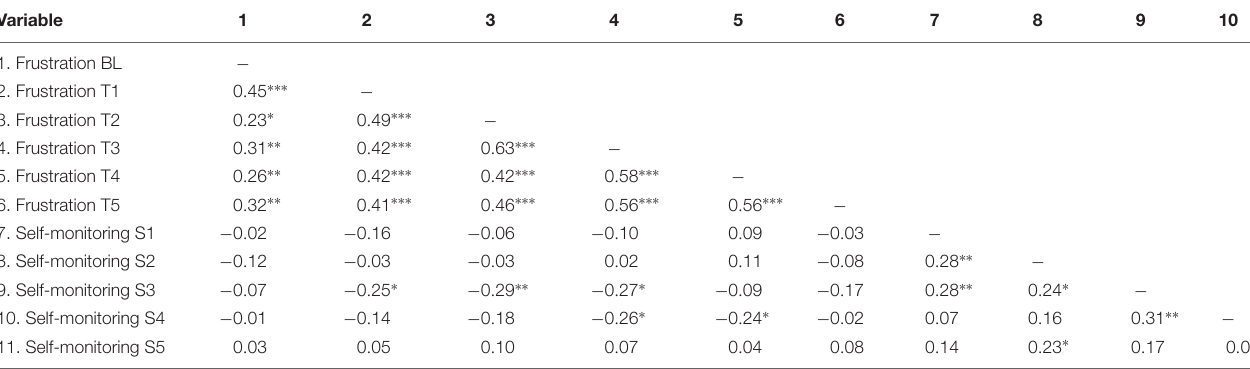
TABLE 5 | Pearson correlations between single measurement occasions of frustration and self-monitoring.